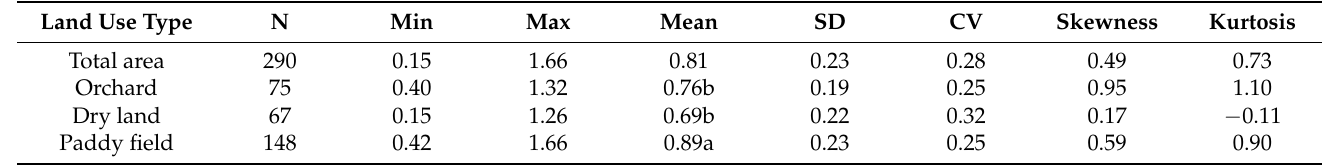
Table 2. The statistics of SOC (%) under total area, orchard, dry land, and paddy